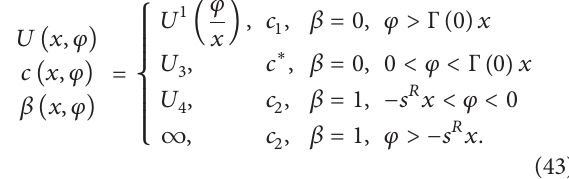
Figure 8: Solution of the auxiliary and lifting system for slug problem in (𝜑,𝑥)